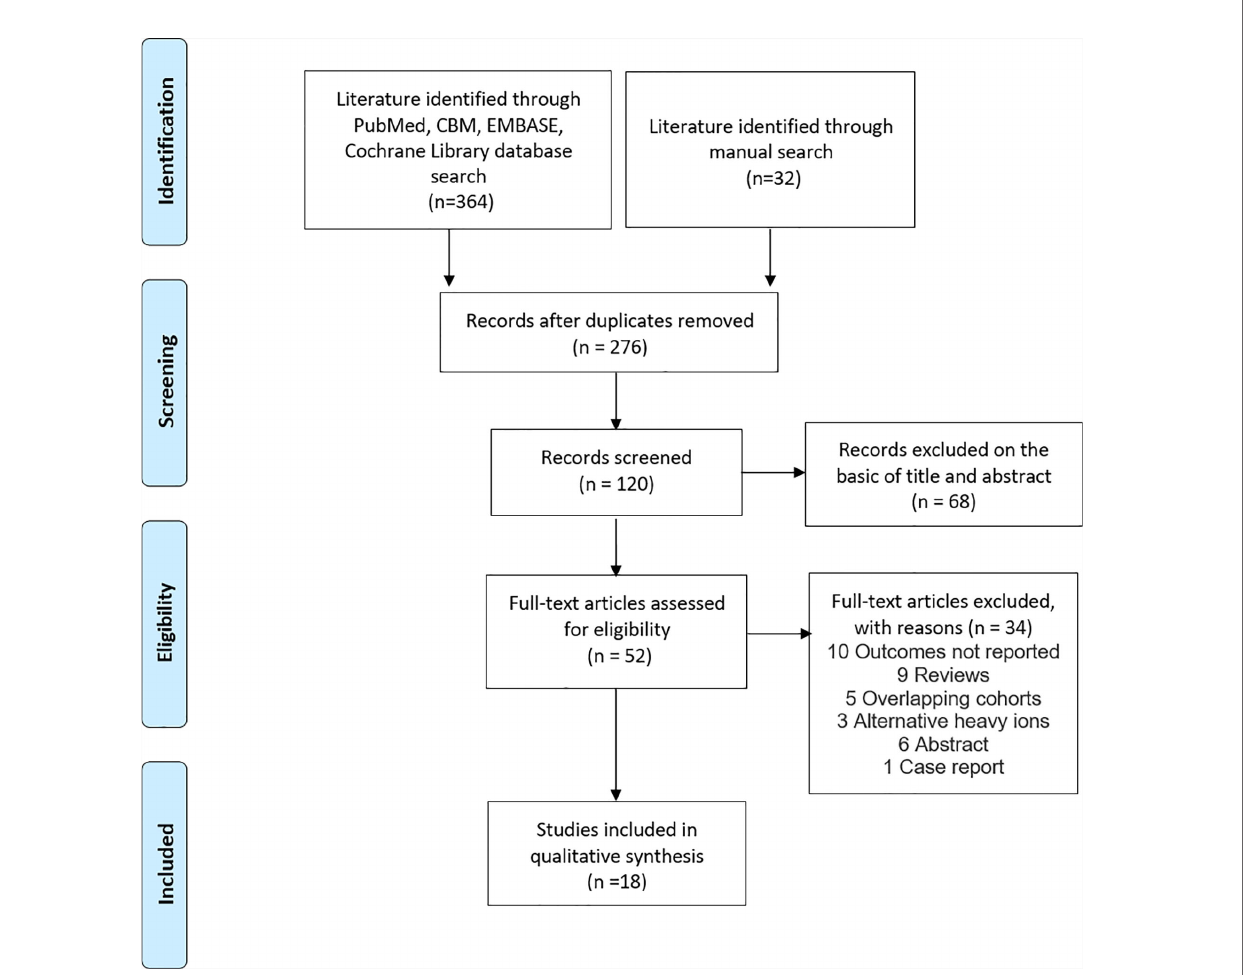
FIGURE 1 | PRISMA fl owchart showing study